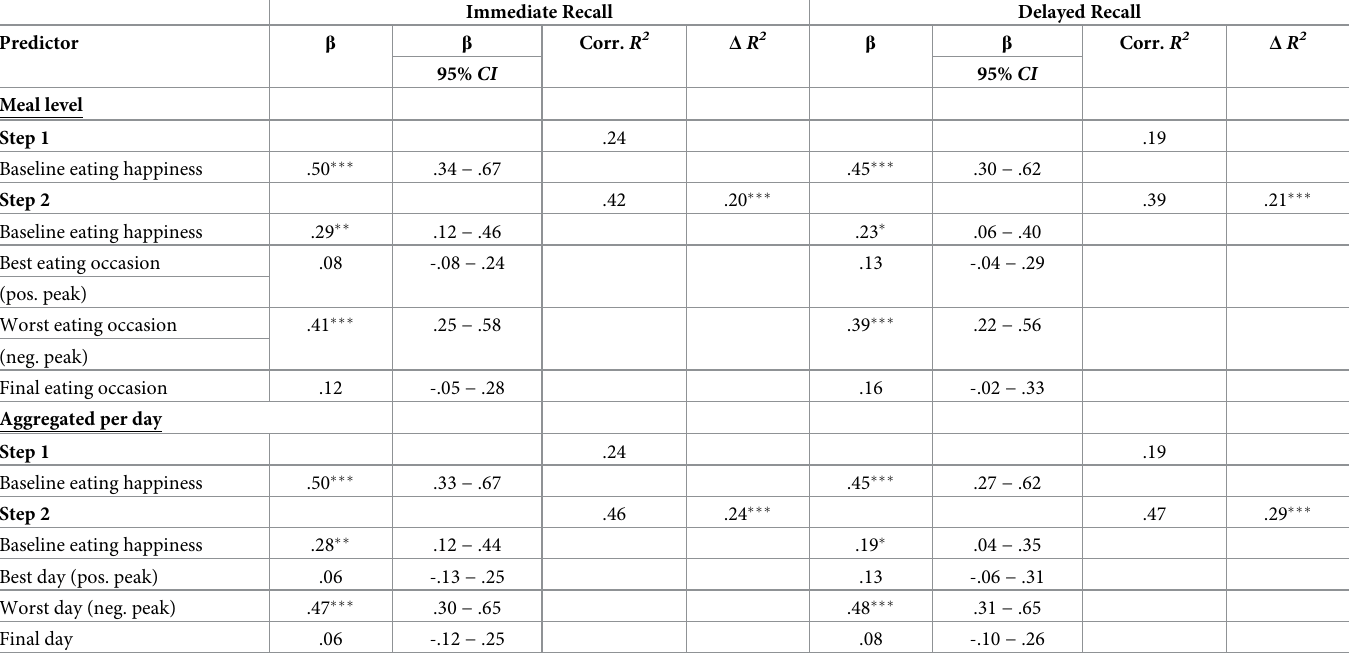
Table 2. Regression results using immediate and delayed recall as the criterion. Analyses aggregated per day revealed a similar pattern of results as analysis on the meal